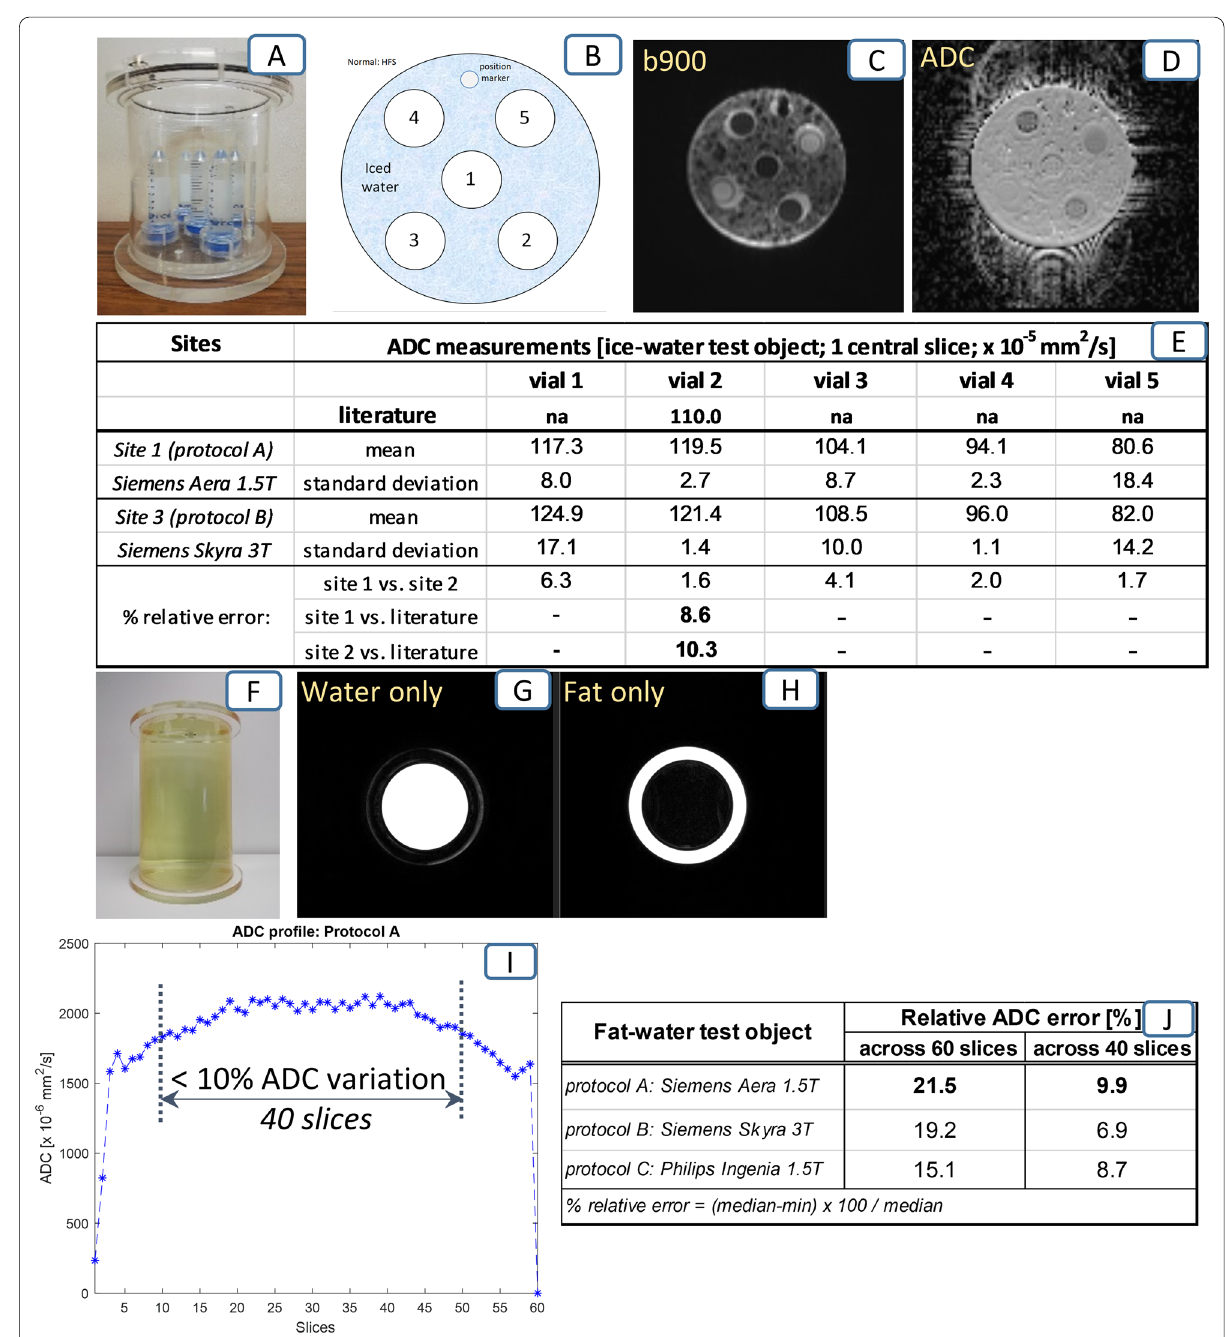
Fig. 2 MR techniques’ assessment using the two specialised test objects. Panels A – E : Temperature‑controlled ADC measurements using the ice‑water test object. Panels F – J : Demonstration of good fat suppression technique using the fat–water test object ( F , G , H ) and good ADC homogeneity along the z ‑direction ( I , J